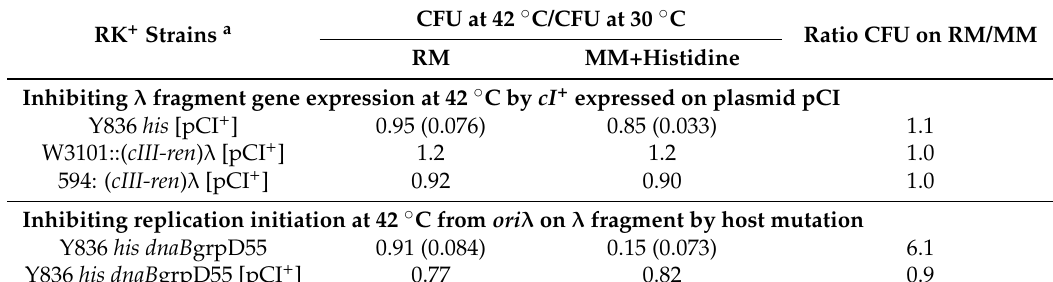
Table 2. Blocking λ gene expression and ori λ replication initiation, or only ori λ